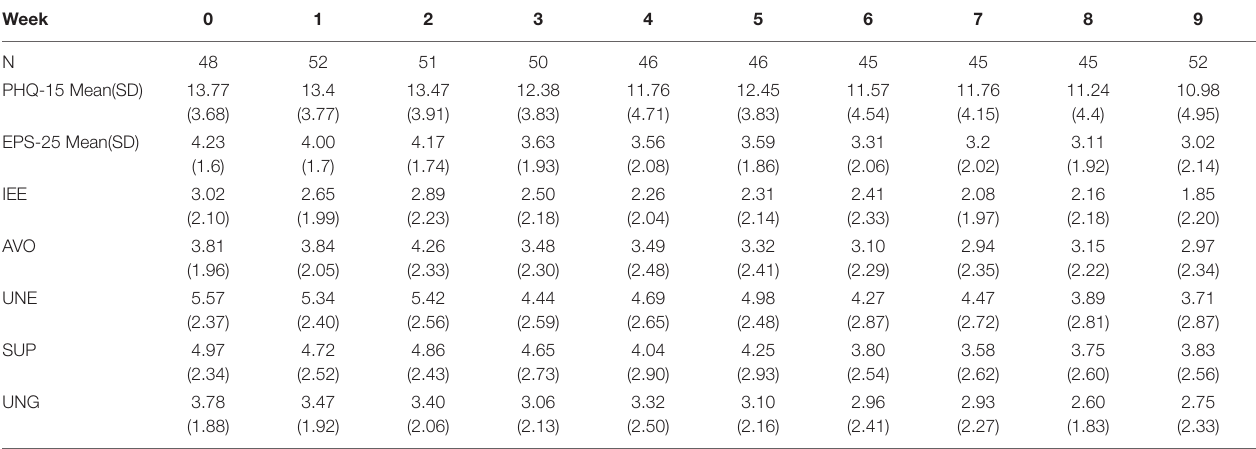
TABLE 1 | Observed means, standard deviations, and number of observations for outcome and processes over the treatment period. Week